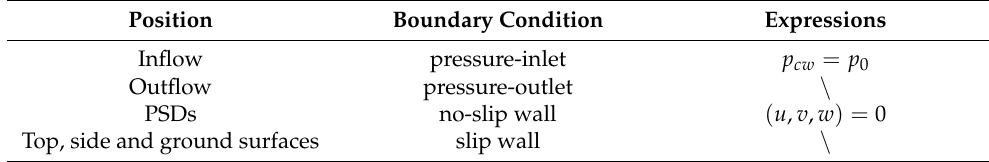
Table 1. Boundary conditions